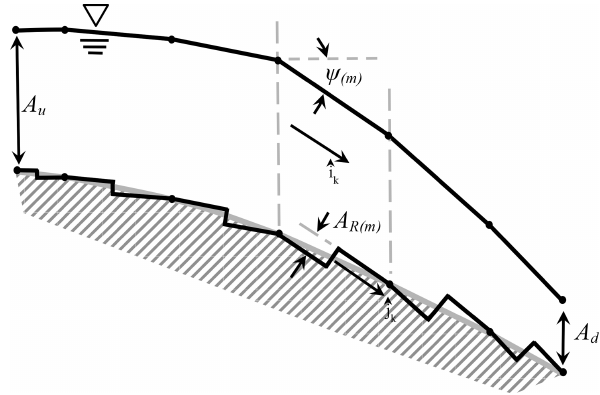
Figure 6. Conceptual model of piecewise linear approximation of nonlinear free surface and stair-step approximation of nonlinear bot- tom with cross-sectional area increasing from A u to the center and then decreasing from the center to A d . Pressure on the discrete riser area A R (m) is locally aligned with the free-surface slope directly above. The vertical scale and thus the tilt of A R (m) are exagger- ated for illustrative purposes. Note that the topography is identical to Fig. 5 but the stair steps are different due to the alteration of the free surface. Figs. 5 and 6 for two different nonlinear water surface pro- files over identical bottom topography. It follows